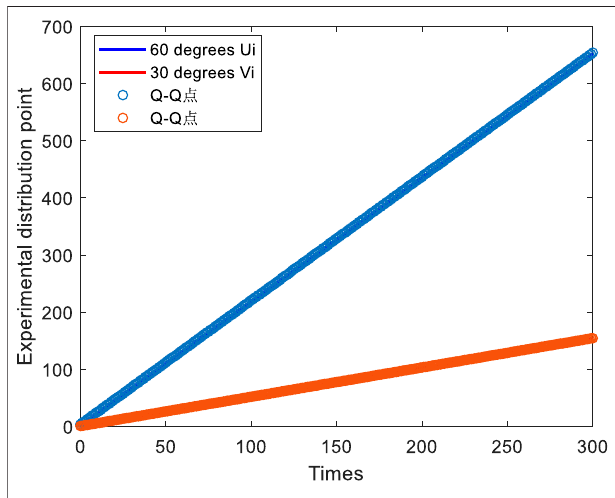
FIGURE 6 | The random delay distribution diagram of the link